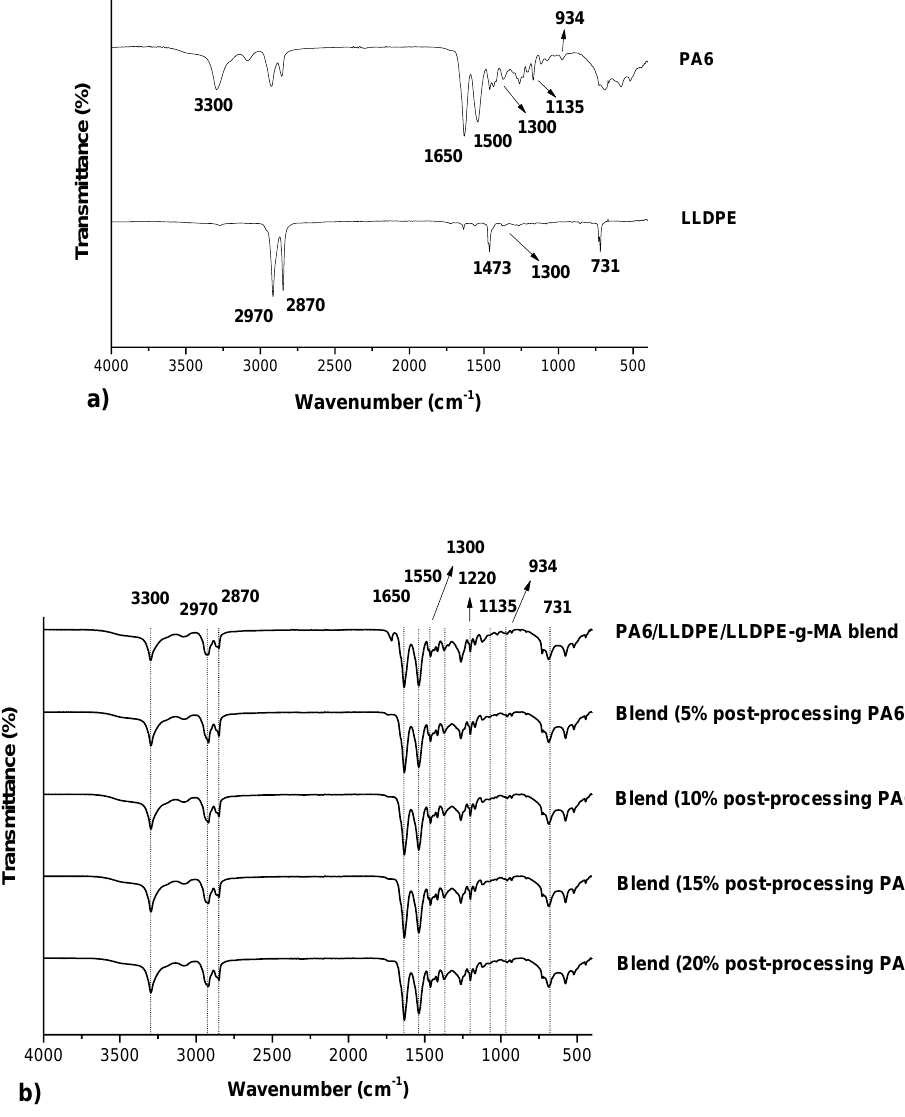
Figure 4. FT-IR spectra of ( a ) neat PA6, neat LLDPE and ( b ) the PA6 / LLDPE / LLDPE- g -MA blends with different post - processing PA6 contents.